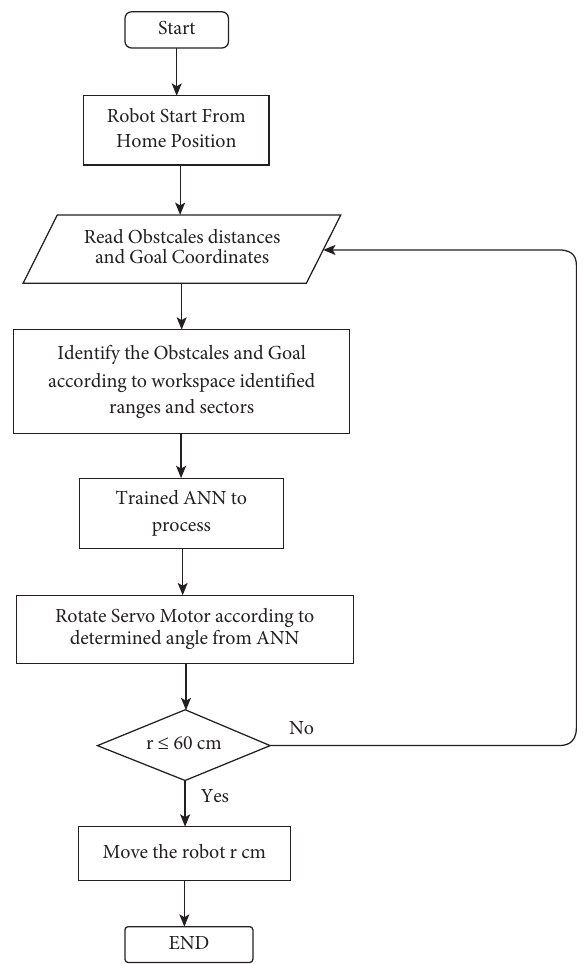
Figure 5: The flowchart of the proposed Table 8: ANN training results using the backpropagation algorithm.